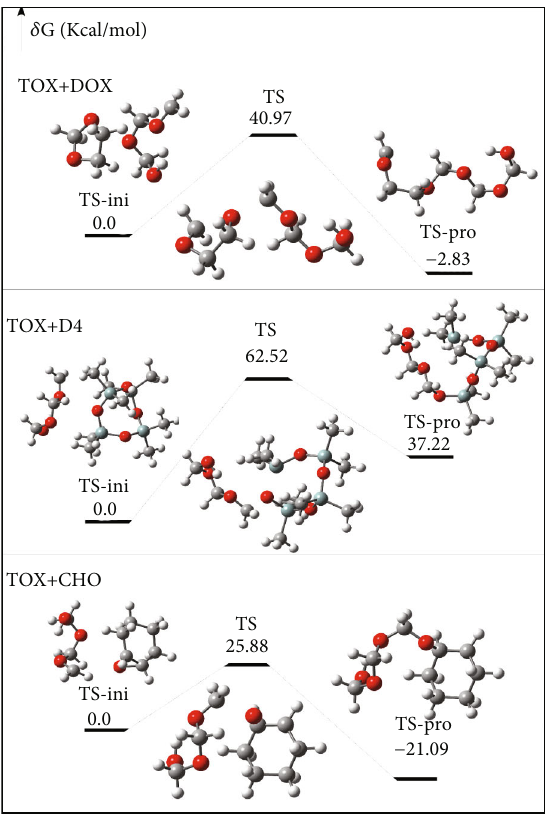
Figure 5: Energy barrier diagram of copolymerization of the second monomer with TOX.